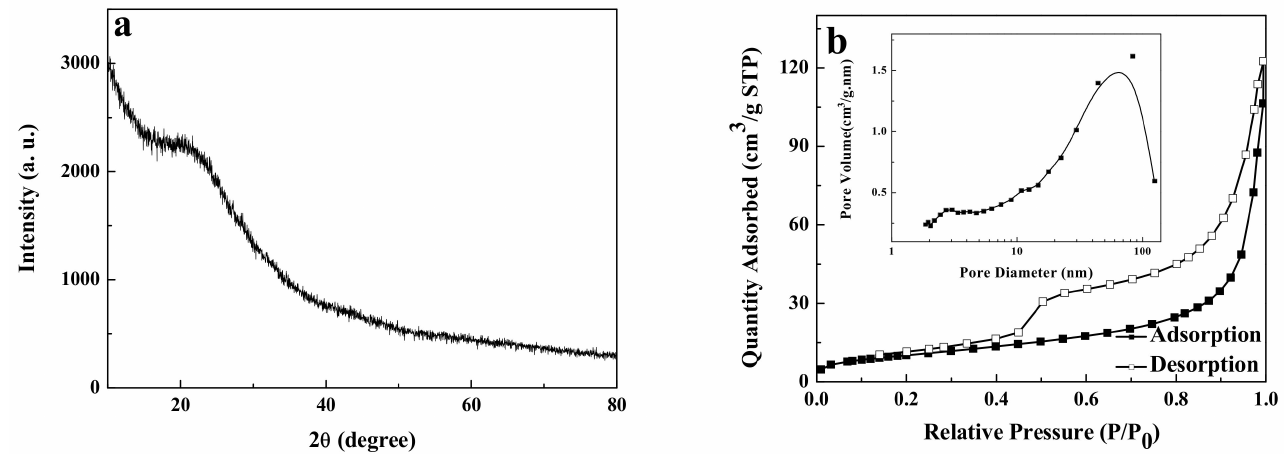
Figure 4. XRD pattern ( a ), and nitrogen adsorption–desorption isotherm ( b ) and pore size distribution (inset) of carbon